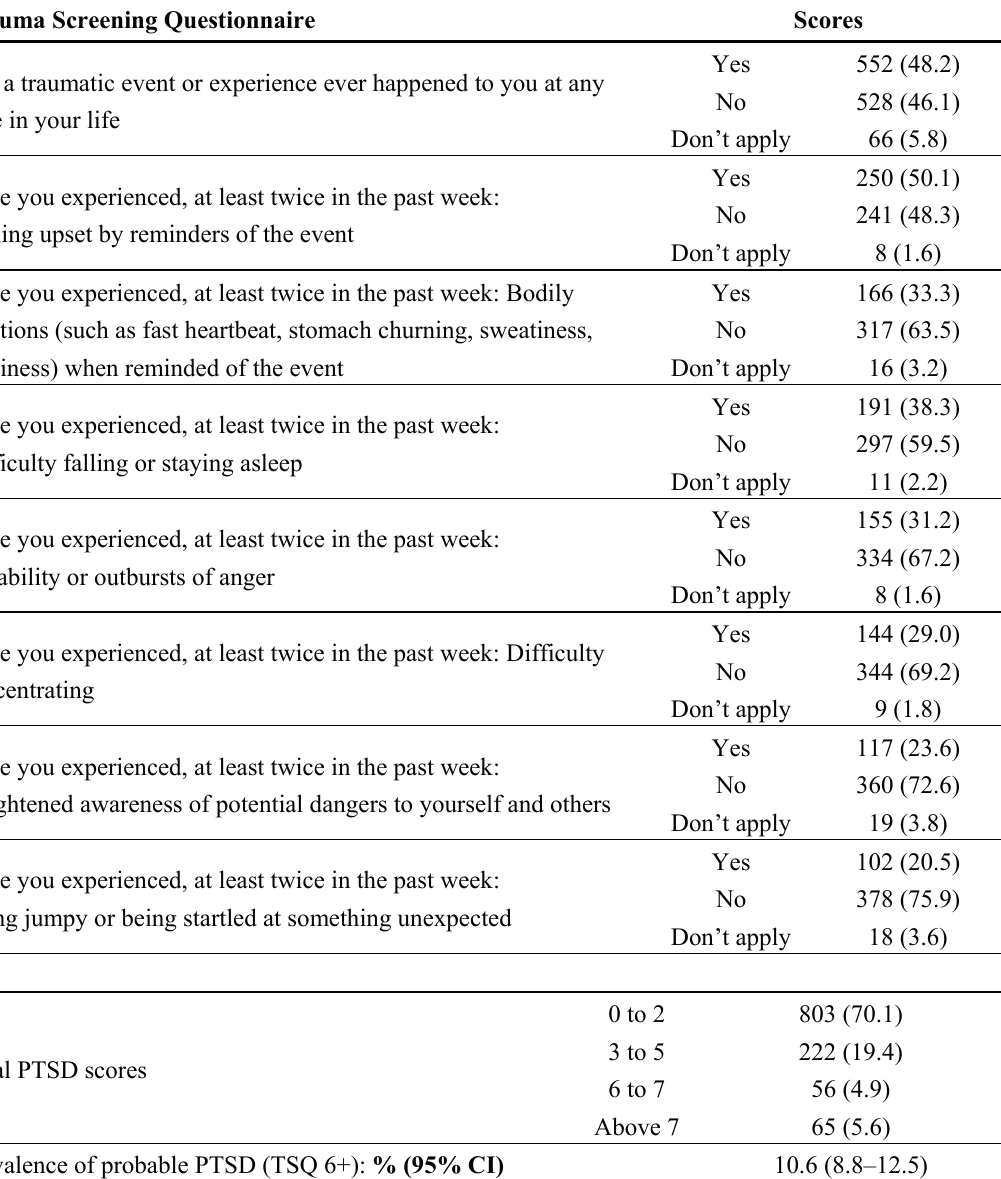
Table 1. Frequency of individual items on the trauma screening questionnaire (TSQ) and the prevalence of probable post-traumatic stress disorder (PTSD) (TSQ score 6+). Trauma Screening Questionnaire